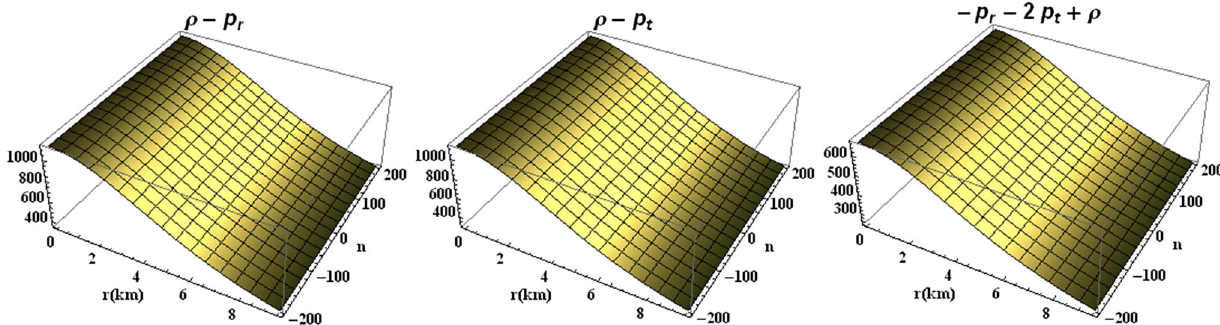
in MeVfm − 3 unit. (Right) Along x -axis, y -axis and z -axis we have respectively plotted the radius of the star in km unit, the dimensionless quantity n which lies in the range − 200 ≤ n ≤ 200 and ρ − p r − 2 p t in MeVfm − 3 unit. All the profiles are drawn for a compact star of mass M = 1 . 85 M (cid:3) and radius of the star = 9 . 5k. by fixing b = 0 . 0095 km − 1